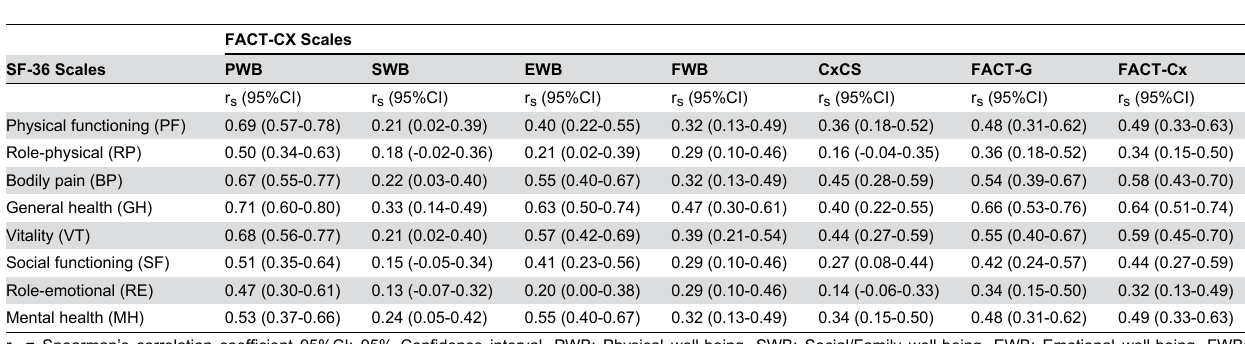
Functional well-being, CxCS: Additional Concerns, FACT-G: PWB + SWB + EWB + FWB, FACT-CX: FACT-G + CxCS. doi: 10.1371/journal.pone.0077947.t005 Table 6. Expected correlations between FACT-CX and SF-36 scales (convergent validity).